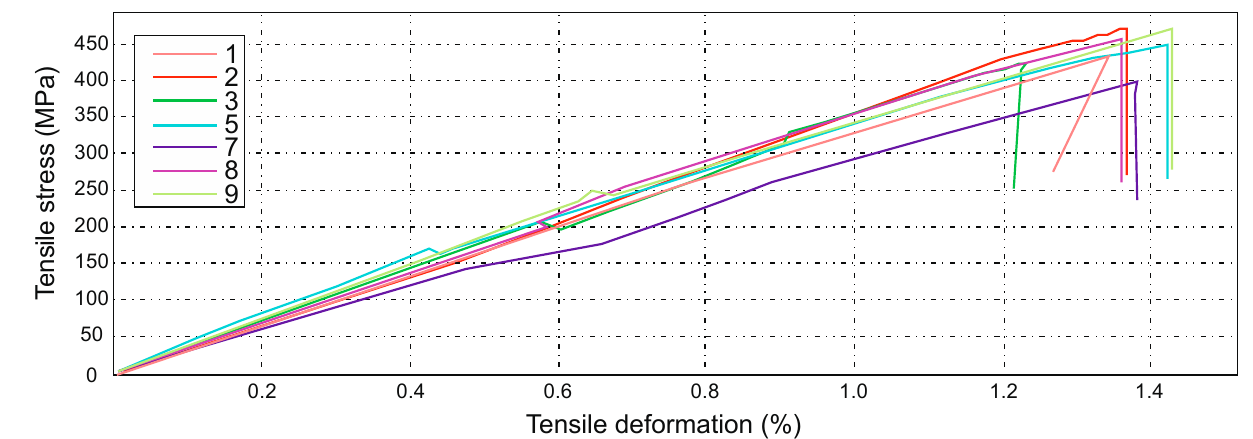
Figure 20. Graph showing the tensile stress and deformation of a laminate reinforced with a symmetrical Interglas 02037, 0/90° configuration.